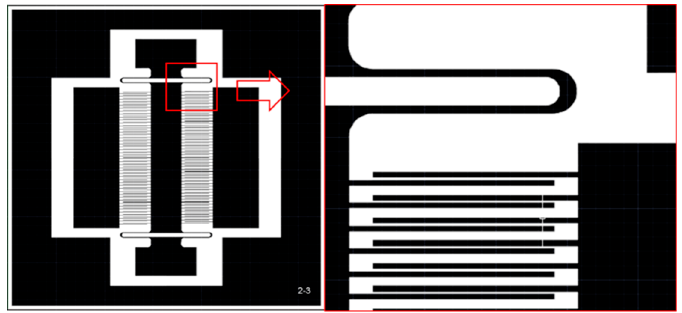
Figure 9. The optimized asymmetric structure design drawings.